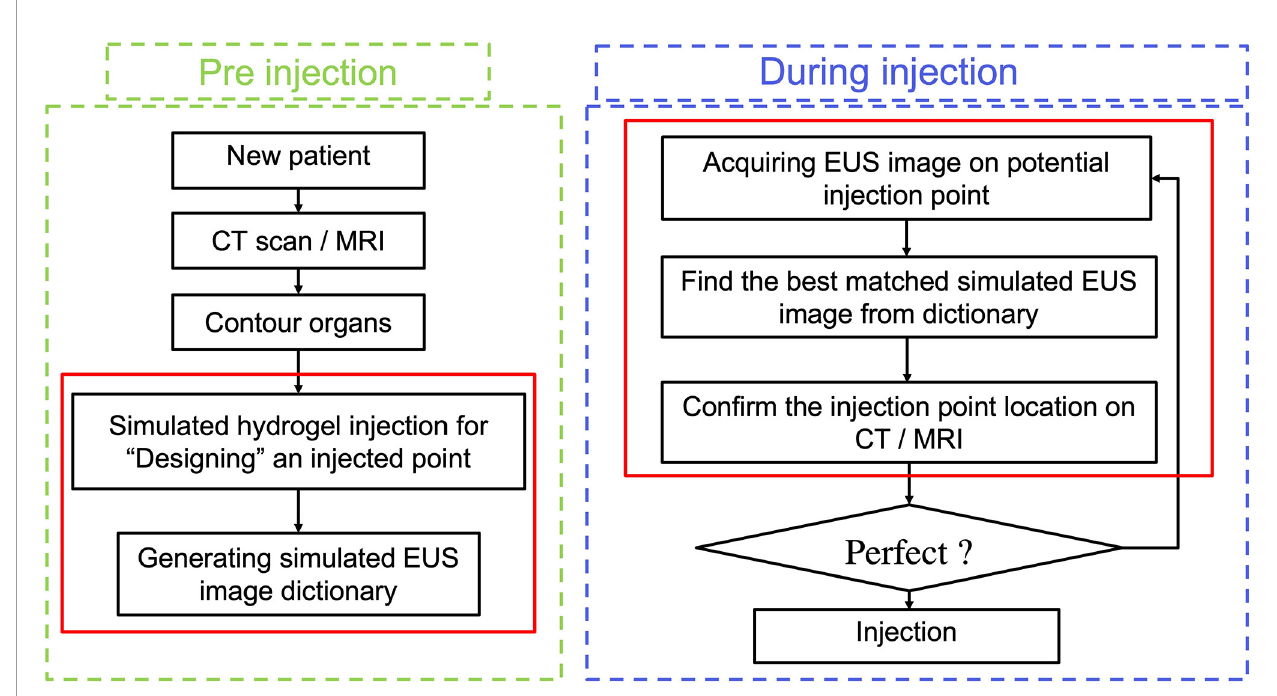
FIGURE 1 | Ideal work fl ow of injecting